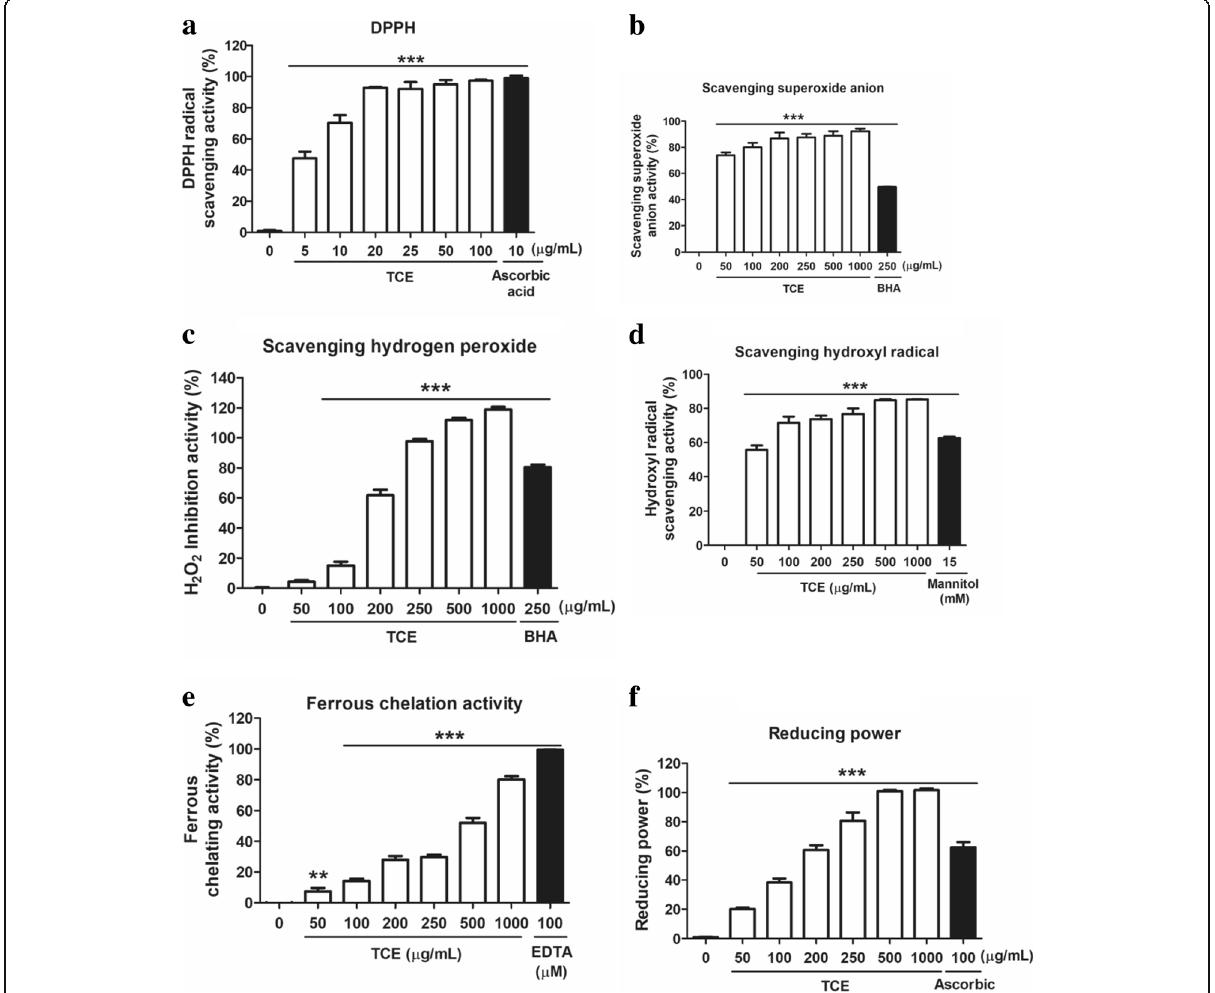
Fig. 1 The aioxidant activity of Terminalia catappa L. methenolic extract (TCE). a 1,1-diphenyl-2-picrylhydrazyl radical scavenging activity of TCE; b Superoxide anion radical scavenging activity of TCE; c Peroxide scavenging activity of TCE; d Hydroxyl radical scavenging activity of TCE; e Ferrous chelating activity of TCE; and f Reducing power of TCE. Significant difference versus control (without extract): * p <0.05; ** p <0.01; *** p